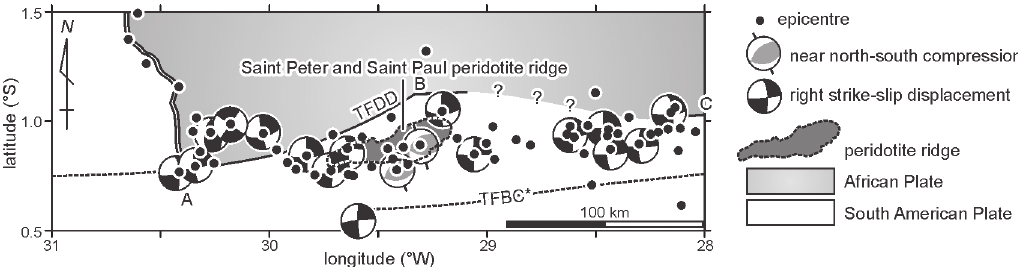
Figure 14 - Epicentres and focal mechanisms of the earthquake of the period from 1971 to 1988 after the data of Wolfe and McNutt